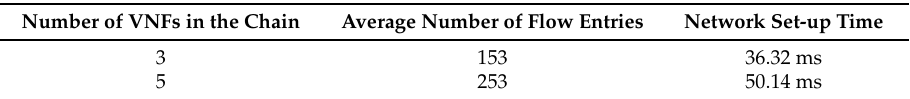
Table 2. Orchestrator performance with different number of VNFs in the chain and with five VNF clouds.